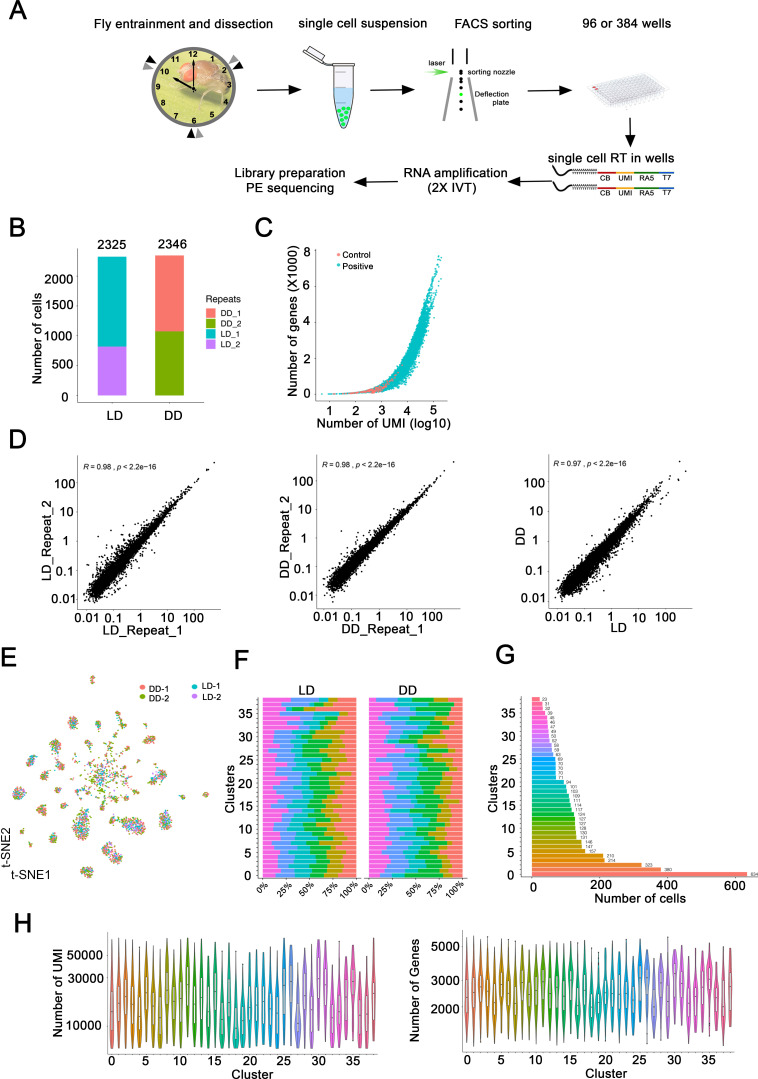
Methods and verification of single-cell RNA sequencing of Drosophila clock neurons.(A) Schematic of single-cell RNA-seq protocol. The method is based on CEL-Seq2 with some modifications. EGFP-labeled clock neurons were sorted into 96- or 384-well plates by fluorescence-activated cell sorting (FACS). CEL-Seq2 primers and two rounds in vitro transcriptions were used to amplify the polyA-tailed mRNA. (B) The number of single cells isolated in each light:dark (LD) and constant darkness (DD) experiments. Two experiments were performed at each condition. (C) Thousands of genes with multiple UMIs each were identified in most single cells. The number of UMIs (x-axis; log10) per gene (y-axis, X1000) in single cells (blue) or negative control wells (red; no cell added) is plotted. Two empty negative control wells were used in each plate assayed. Negative control wells have no or very few genes been detected. (D) Gene expression correlation between replicates and conditions. Comparisons between two LD experiments (left panel), two DD experiments (middle panel), between one LD and one DD experiment (right panel) are shown. The cells collected in two replicates and conditions were pooled and further analyzed as pseudo-bulk samples. (E) t-SNE plot of all single cells from four separate experiments illustrates that each cluster contains a mix of cells from each experiment. Two LD and two DD experiments were co-clustered in each cluster, each dot represents a single cell and colored by repeats. Two independent DD experiments are shown in pink and green. Two independent LD experiments are show in blue and purple. (F) Bar plots showing the percentage of cells in that cluster that come from each of the six timepoints collected. Each cluster has relatively similar numbers of cells from each of the timepoints in both LD and DD experiments. (G) The number of single cells assigned to each cluster. This includes cells from all timepoints in both LD and DD conditions. (H) Violin plots showing the number of detected UMIs and genes in each cluster. Each cluster has relatively similar numbers of genes and UMIs. Numbers on the x-axis represent 39 clusters.